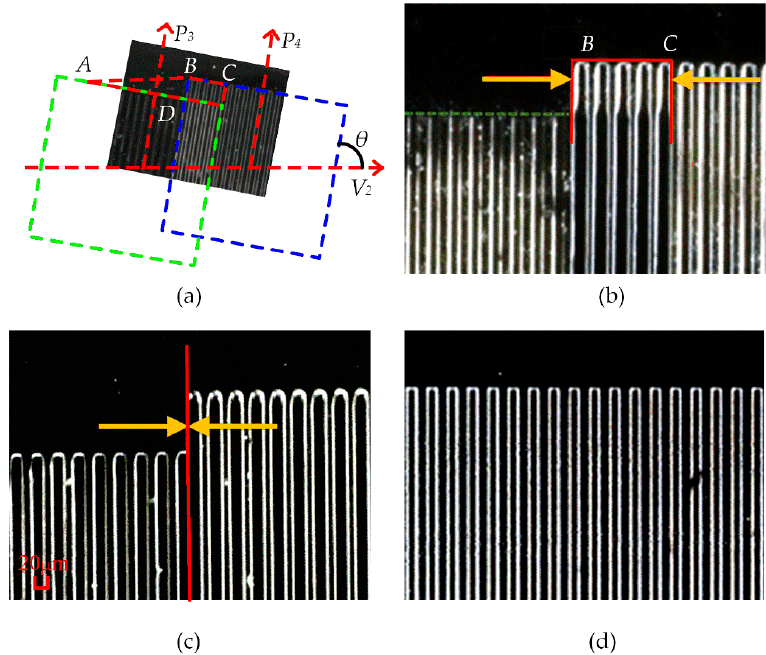
Figure 11. Several grating images of alignment: ( a ) Principle of the splicing lithography method ( b ) Overlaps of the first lithography ( c ) Overlaps of first lithography after adjusting ( d ) Third lithography after achieving precise alignment.